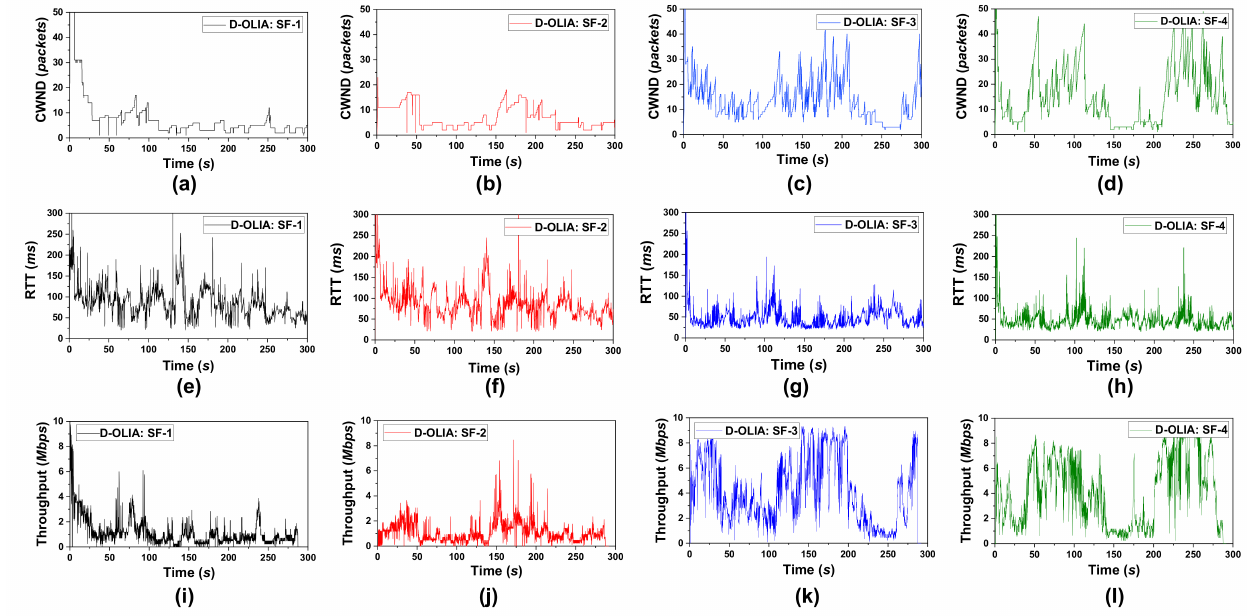
Figure 10. Performance of D-OLIA’s four SFs for Scenario #3 in terms of ( a – d ) CWND, ( e – h ) RTT, and ( i – l )